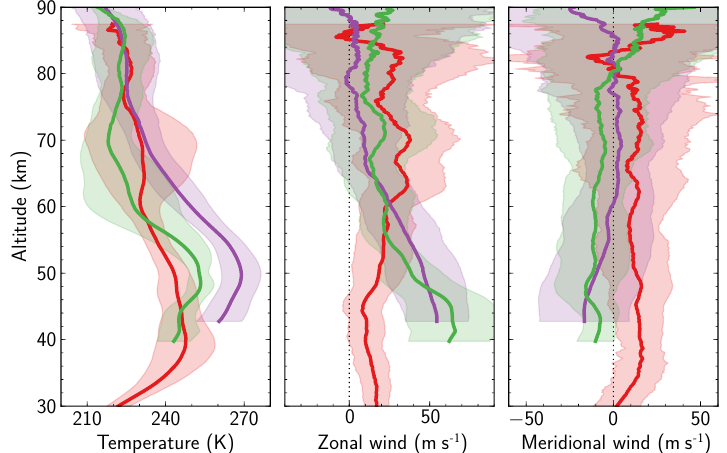
Figure 1. January mean temperatures and horizontal winds derived by lidar for the years 2012 (red), 2014 (purple), and 2015 (green). Shaded areas represent the corresponding standard deviations (SDs).